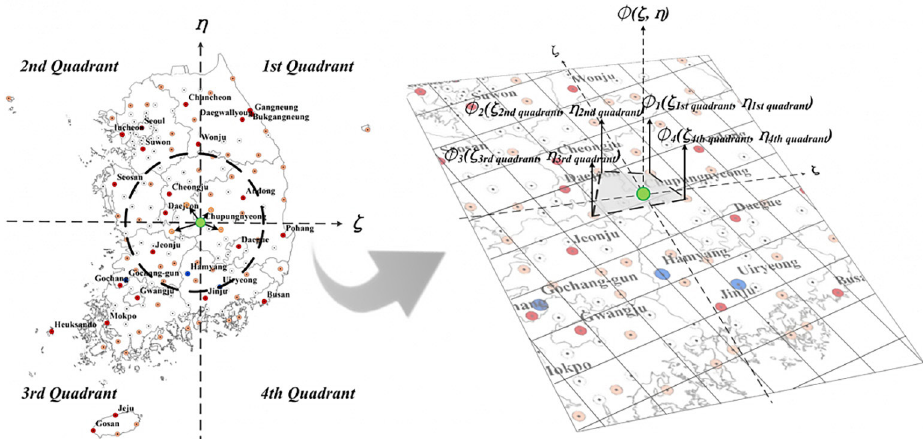
Fig. 5. Concept of the Lagrangian shape function in quadrilateral